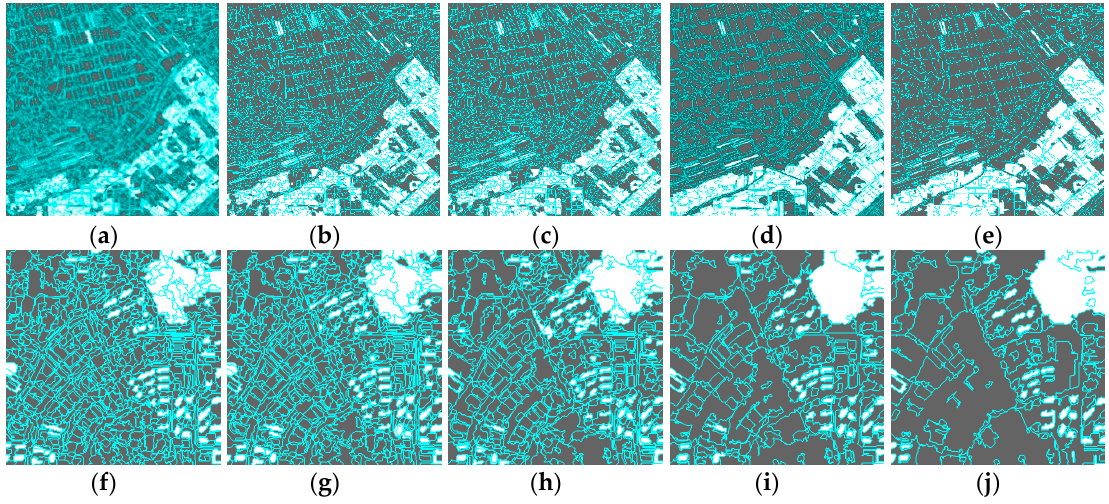
Figure 17. CD results using different segmentation scales overlapped with the segment boundaries at Sites 1 and 2: ( a , f ) scale 30; ( b , g ) scale 50; ( c , h ) scale 100; ( d , i ) scale 200; and ( e ,j) scale 300.